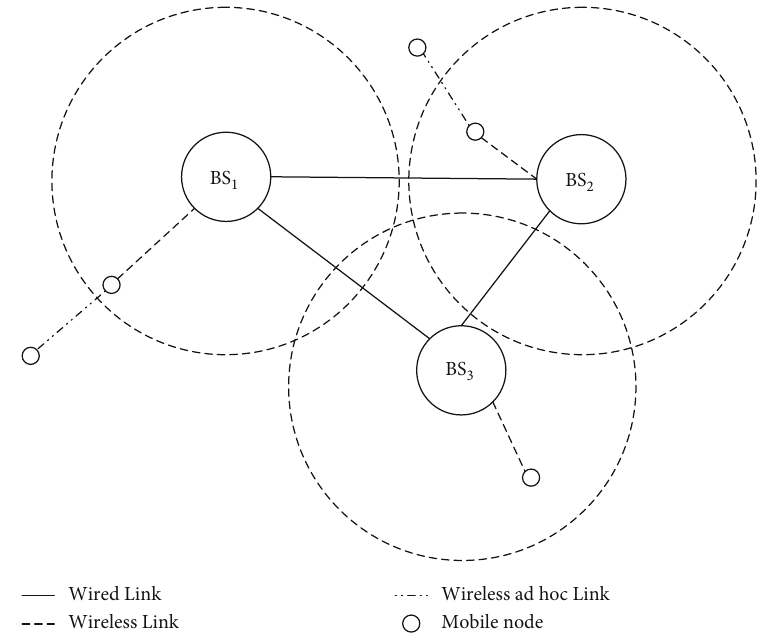
Figure 1: A sample hybrid wireless ad hoc